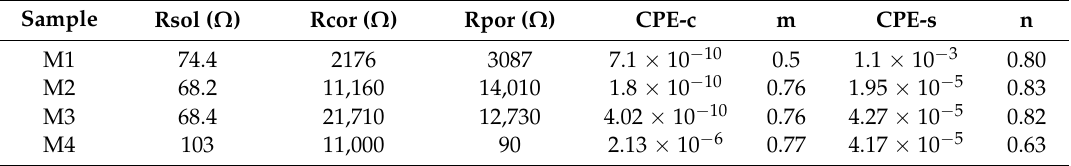
Table 5. Values of the parameters obtained after the fit of the proposed equivalent circuits to the coatings produced, after exposure times of 168 h. CPE: constant phase